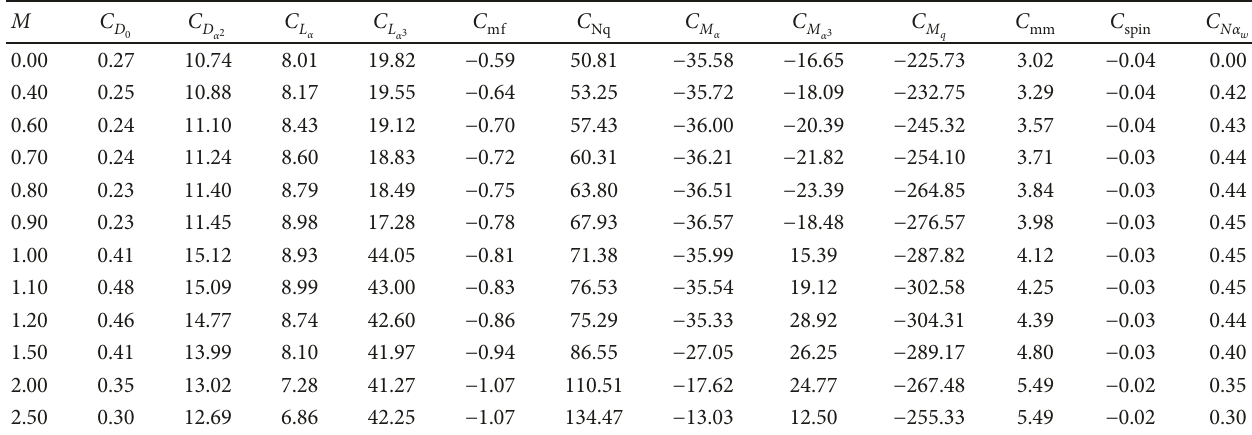
Table 1: Aerodynamic coe ffi cient interpolation table in function of the Mach